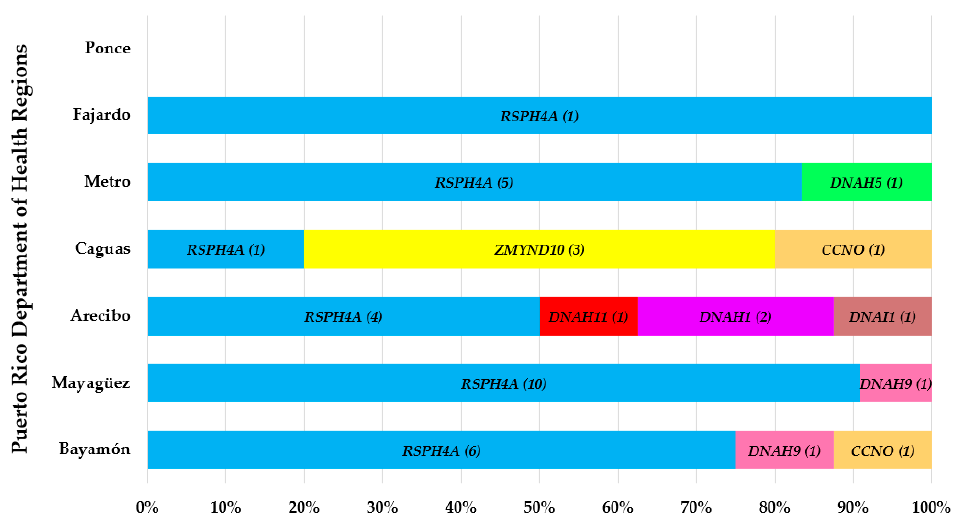
Figure 3. Percentage and number of total allele frequency of PCD pathogenic variants in Puerto Rico. The pathogenic variant (c.921+3_6delAAGT) in the RSPH4A gene was the most frequent.